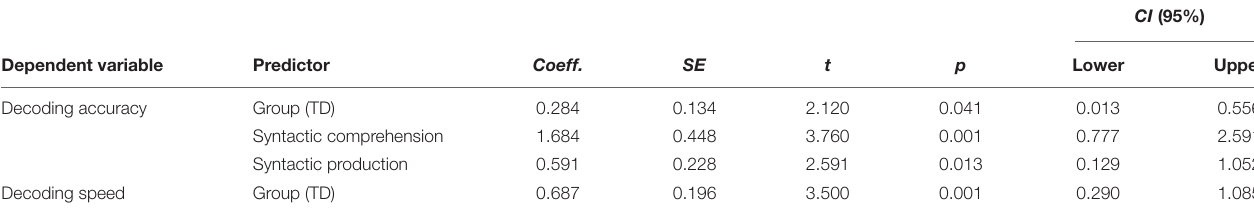
TABLE 2 | Predictive fixed effects of group and syntactic skills on decoding standard scores.